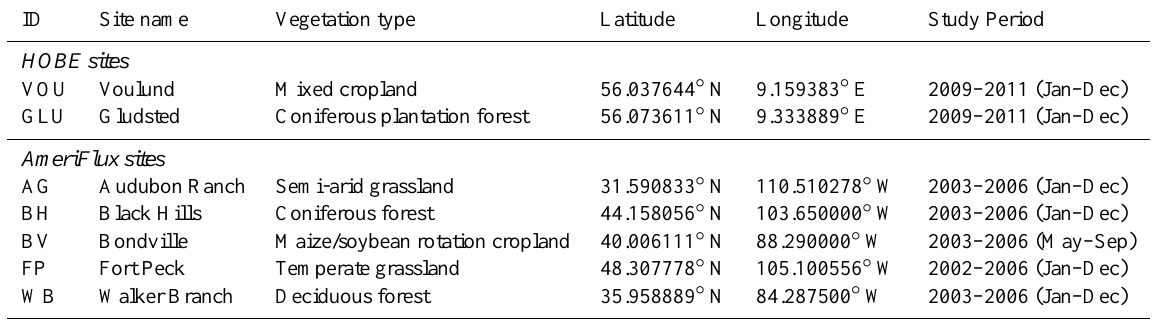
Table 1. List of flux towers providing the validation datasets used in this study. Information includes the ID and name of the flux tower, the vegetation type in the vicinity of the tower, its location and the period of the data series